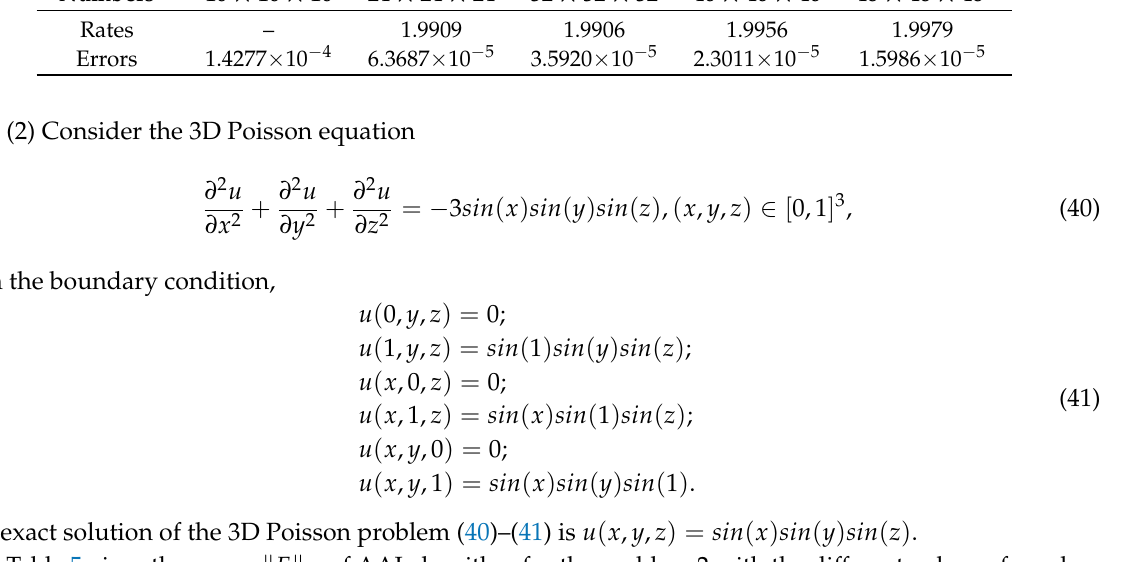
E ∞ of the presented iterative algorithm when (cid:107) (cid:107)